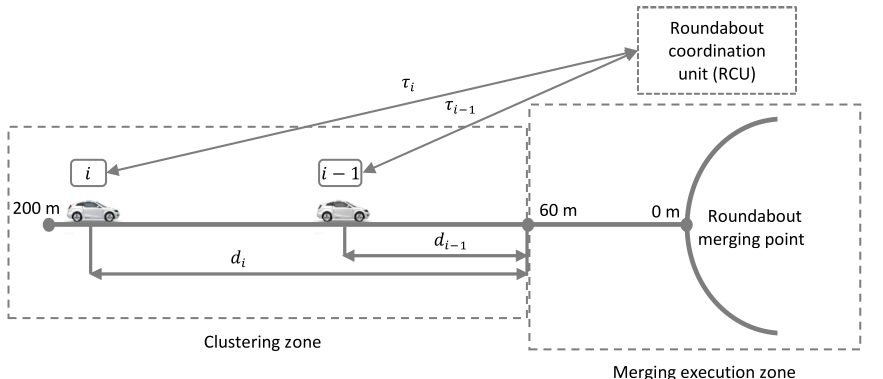
Figure 3. Illustration of the principle to determine the necessity of forming vehicle clusters (higher level coordination). The RCU computes the optimal arrival time of vehicles i − 1 and i